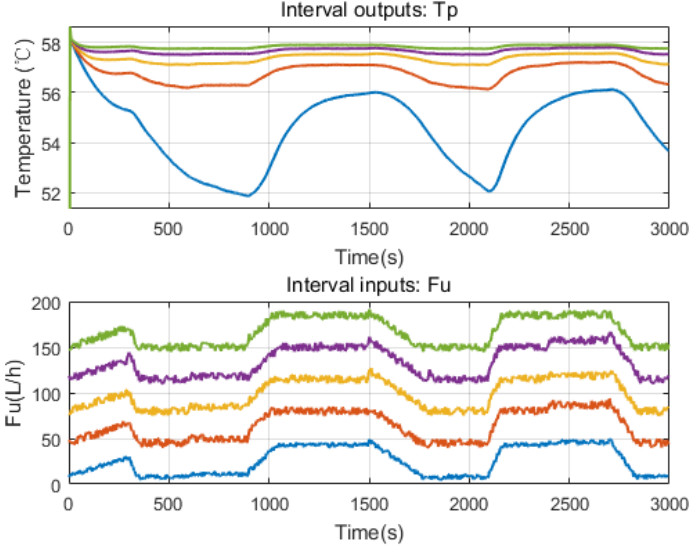
Figure 2. The interval inputs and outputs from virtual experiments (the color indicates the IO